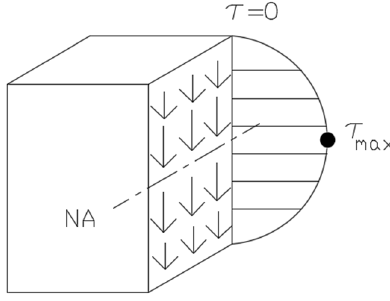
Figure 2. Transverse shear stress distribution for a rectangular cross-section.